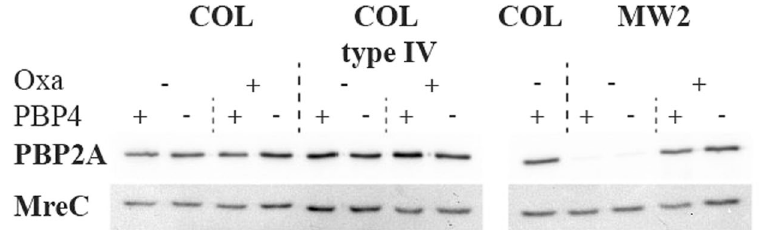
Figure 2. Western blot analysis of PBP2A expression levels. Total protein extracts of COL, COL type IV, MW2 and their PBP4 mutants grown in the presence and absence of 0.5 µ g/ml oxacillin (Oxa) were separated by 10% SDS-PAGE gel and assessed for PBP2A expression using anti-PBP2A antibody (top panel). The same PVDF membrane was probed using anti-mreC antibody as a loading control (bottom